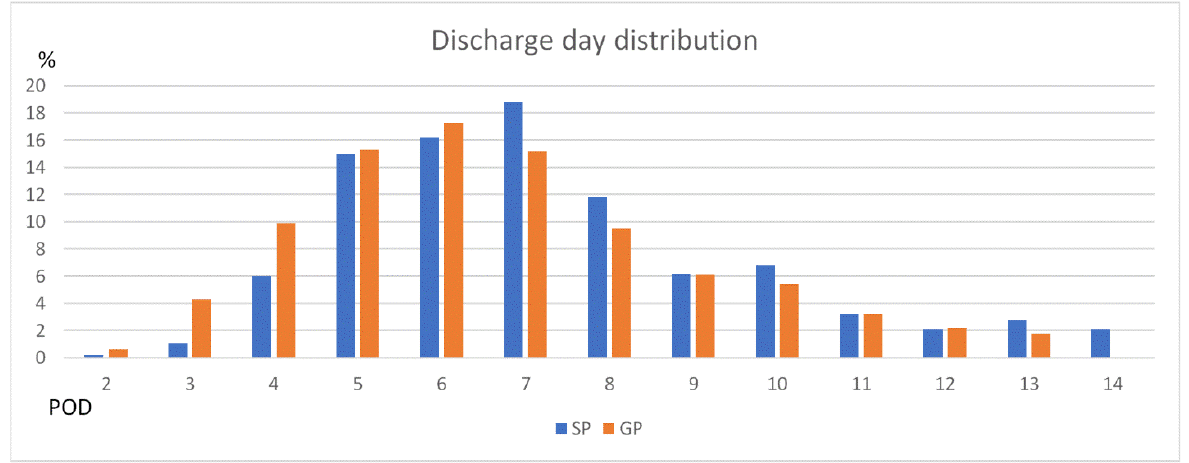
Figure 2. Histogram showing the distribution of postoperative hospital stay for the study population according to solo practice (SP) and group practice (GP) . POD = postoperative day.